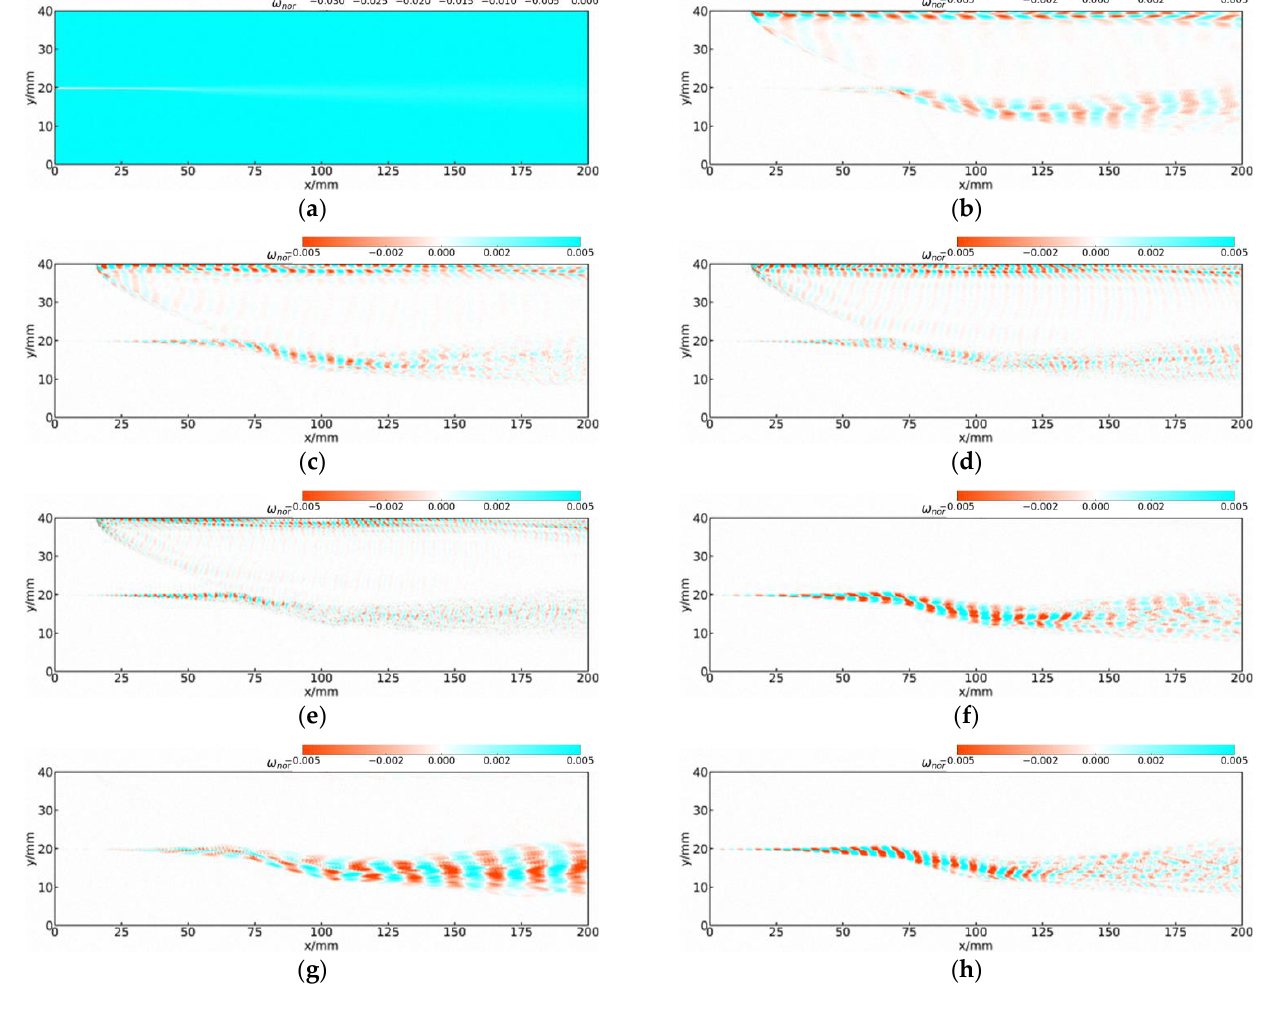
Figure 16. Dimensionless vorticity contour of the first eight modes in Case 2: ( a ) the 1st mode; ( b ) the 2nd mode; ( c ) the 3rd mode; ( d ) the 4th mode; ( e ) the 5th mode; ( f ) the 6th mode; ( g ) the 7th mode; ( h ) the 8th mode.